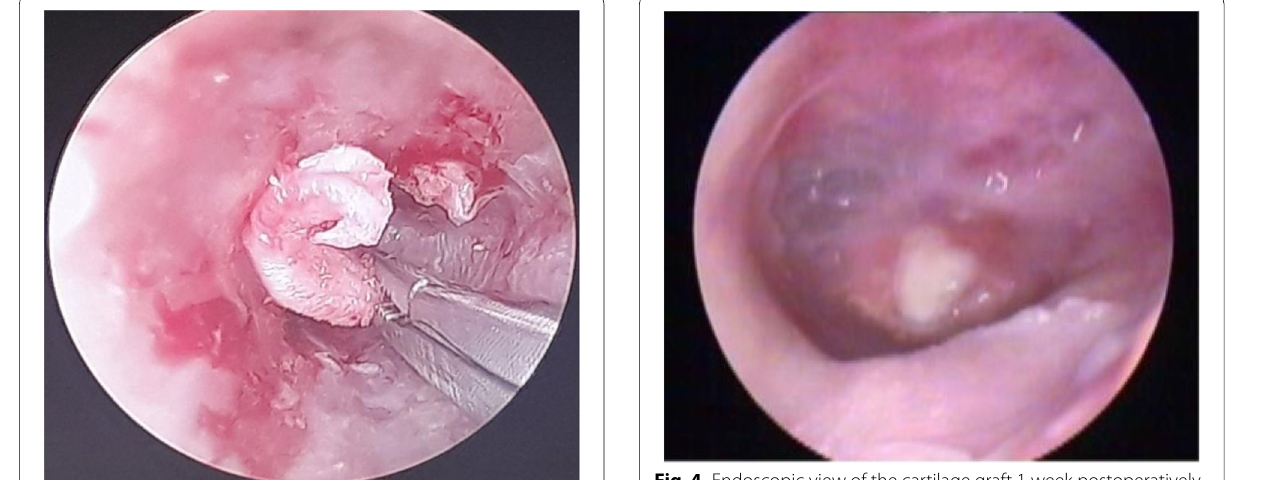
Fig. 4 Endoscopic view of the cartilage graft 1 week